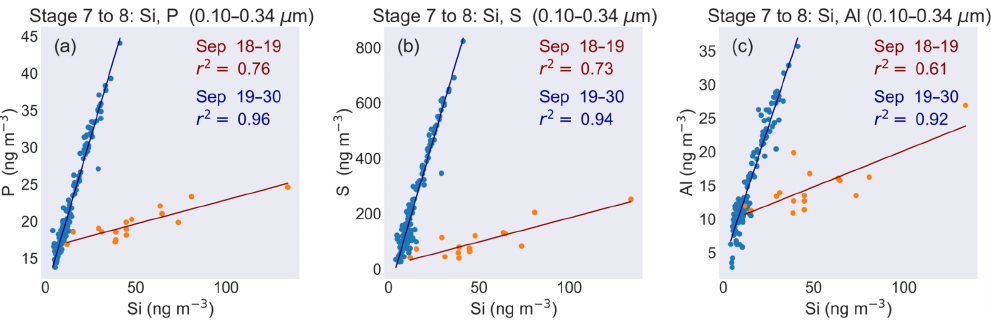
Figure 8. Linear regressions of ultrafine Si and its most highly correlated elements, (a) P, (b) S, and (c) Al, divided into the cruise periods before 19 September (red) and after 19 September